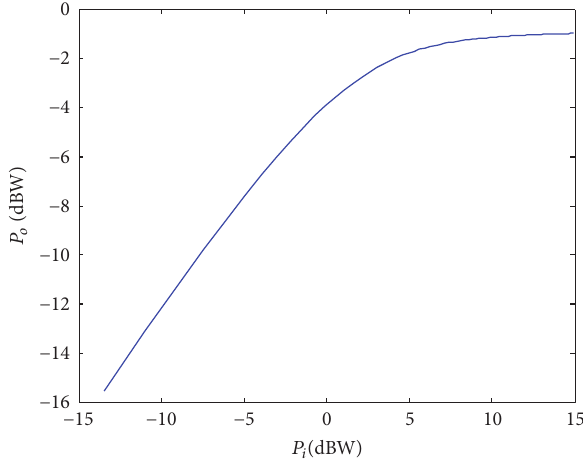
Figure 7: Amplifier output noise power spectral density with 𝑃 𝑖 = 0 dBW, 𝐵 notch = 2 MHz, and notch depth = 80 dB.